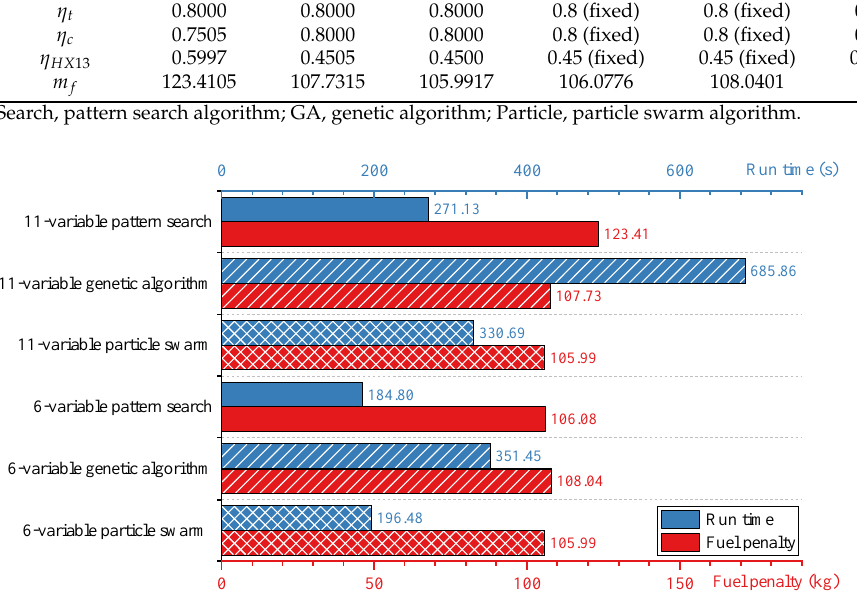
Figure 9. Comparison of optimization results and run